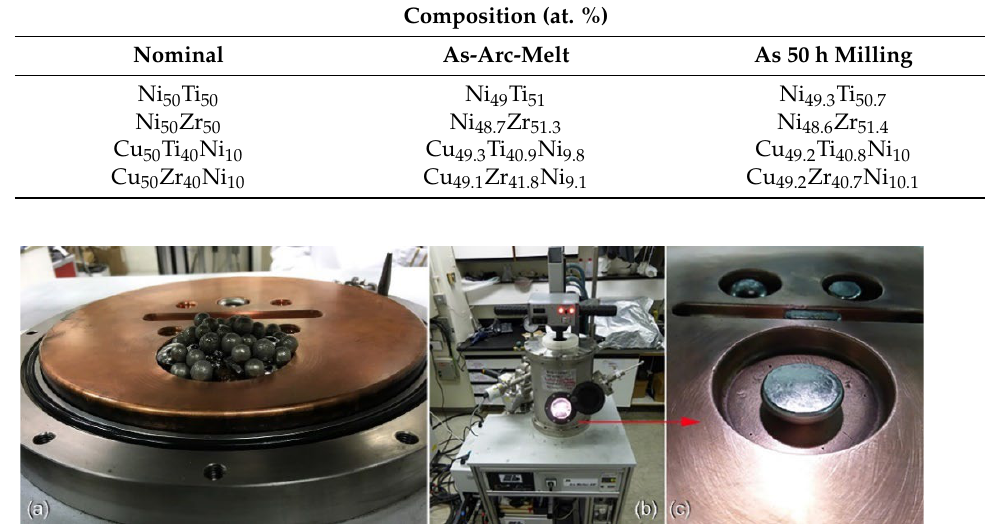
Table 1. Compositional analysis performed by scanning electron microscopy (SEM)/energy-dispersive X-ray spectroscopy (EDS) of as-arc-melt and high-energy ball milling materials. Composition (at. %) Nominal As-Arc-Melt